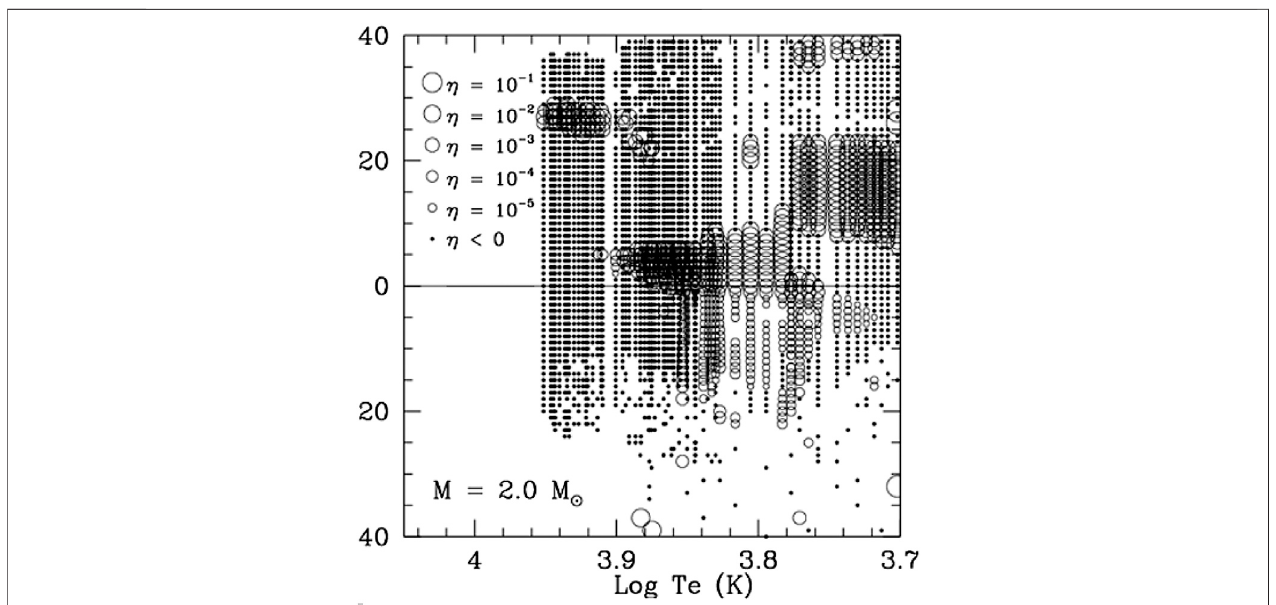
FIGURE 6 | Stable (small fi lled circles) and unstable (open circles) low-degree ( l (cid:2) 2 ) non-radial modes in the ( n − log T e ) plane for evolutionary models of a M (cid:2) 2 . 0 M ⊙ star,where n (cid:2) n p − n g istheradialorderofmodes,and n p , n g are,respectively,thenodenumberofp-andg-modes(Unnoetal.,1989).Thesizeoftheopen circles is proportional to the logarithm of the amplitude growth rate of the modes.